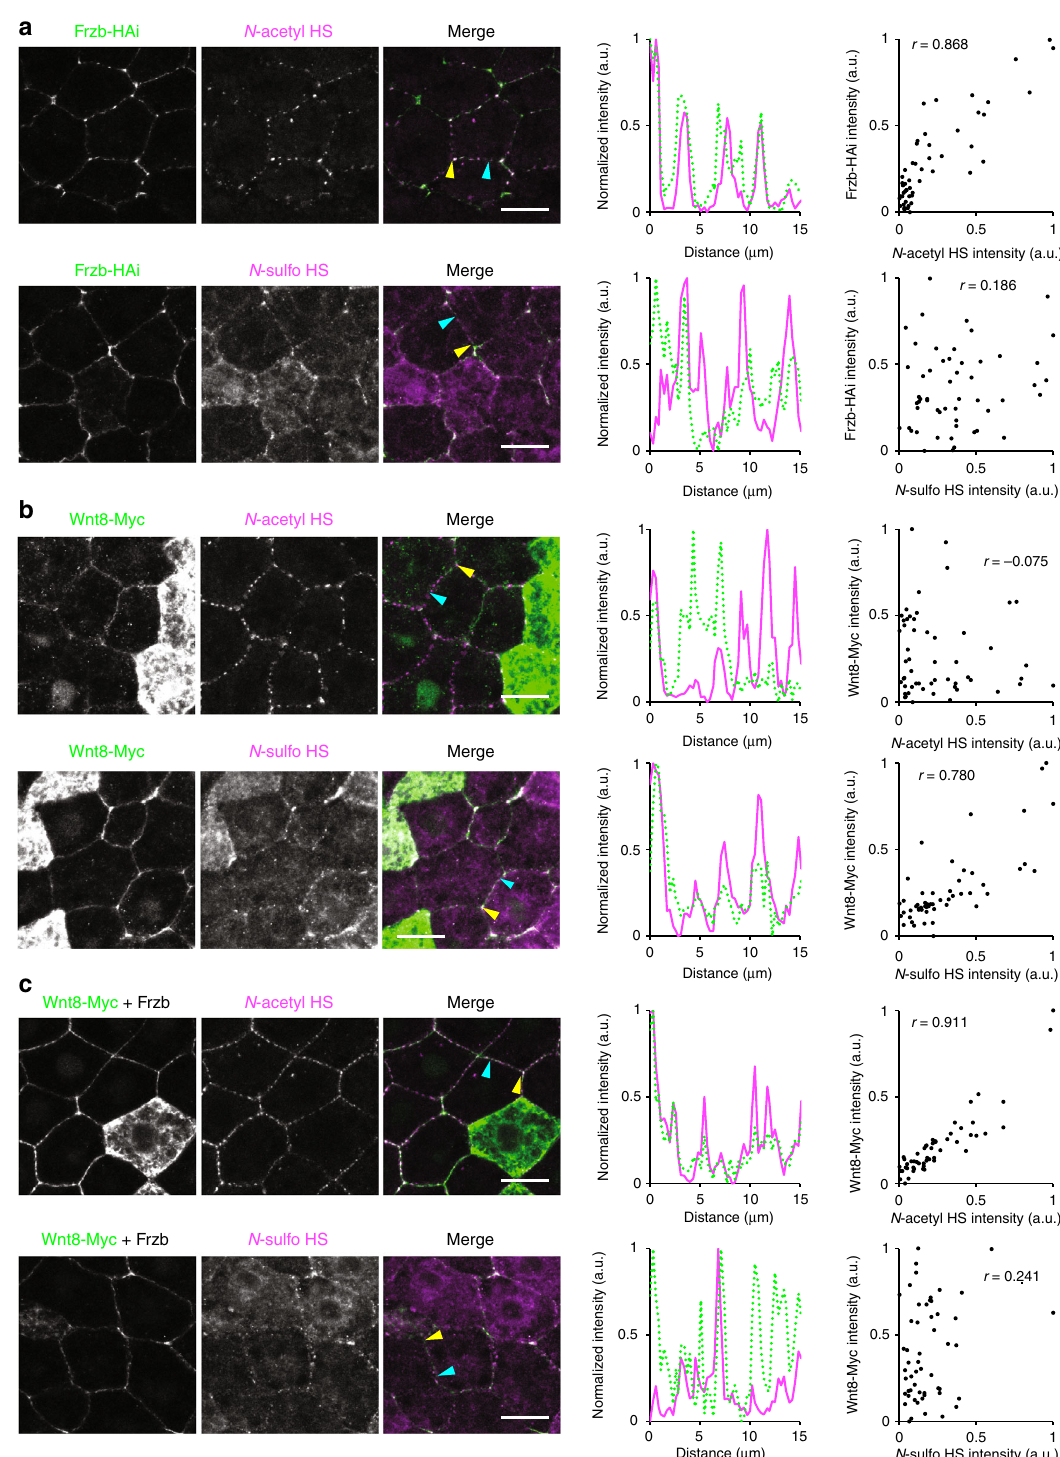
Fig. 9 Frzb and the Wnt8 – Frzb complex accumulates on N- acetyl-rich HS clusters. Intercellular distributions of HS and Wnt8 or Frzb in the Xenopus embryo (st. 10.5) were visualized by immunostaining (1st to 3rd panels from the left). Normalized intensities of Frzb-HAi or Wnt8-Myc (green) and HS (magenta) along the cell boundaries were plotted in graphs (4th panels). The start and end points are indicated by yellow and cyan arrowheads, respectively, in the merged pictures. Paired sets of normalized intensities of N- acetyl and N- sulfo signals at each position were plotted (5th panels). Values of calculated correlation coef fi cients ( r ) are shown in the graphs. a Frzb-HAi. Internally HA-tagged Frzb (Frzb-HAi) preferentially colocalized with N- acetyl HS compared to N- sulfo HS. b Wnt8-Myc. Conversely, Wnt8-Myc preferentially colocalized with N- sulfo HS compared to N- acetyl HS. c Wnt8-Myc in the presence of Frzb. When Frzb was expressed adjacently, Wnt8-Myc became colocalized preferentially to N- acetyl HS similar to Frzb-HAi. Images are a representative of four independent experiments. Amounts of mRNAs (ng/embryo): frzb-HAi 0.25; wnt8-myc , 0.25; for frzb , 1.0. Scale bars, 20 μ m. a.u., arbitrary units